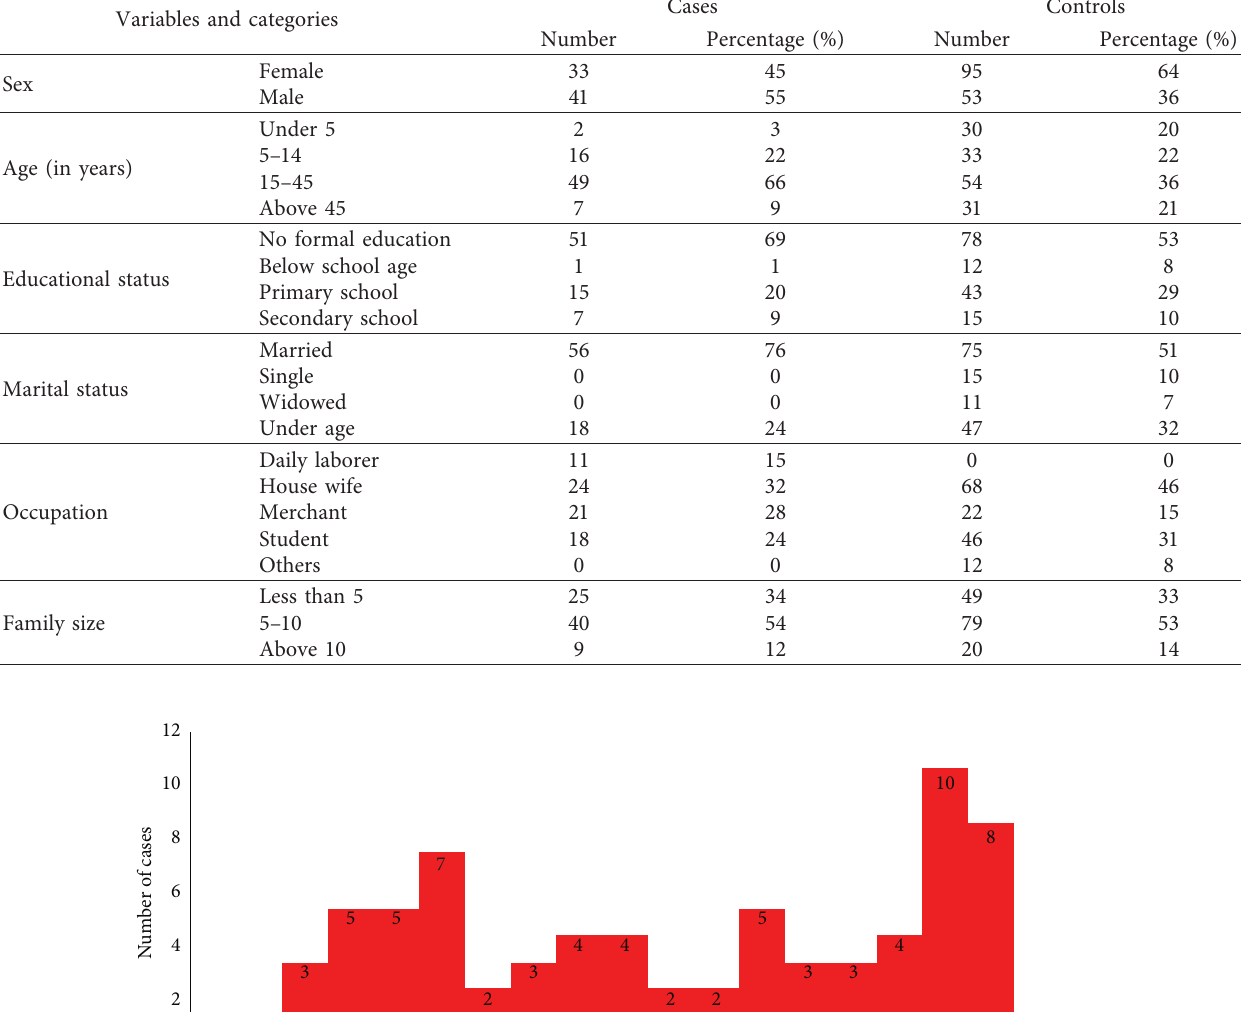
Table 1: Sociodemographic characteristics of study participants, Kebridahar City Administration, Korahe zone of Somali region, Ethiopia, 2019.